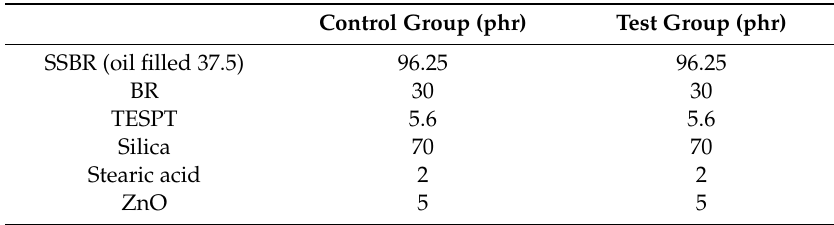
Table 2. The compounds